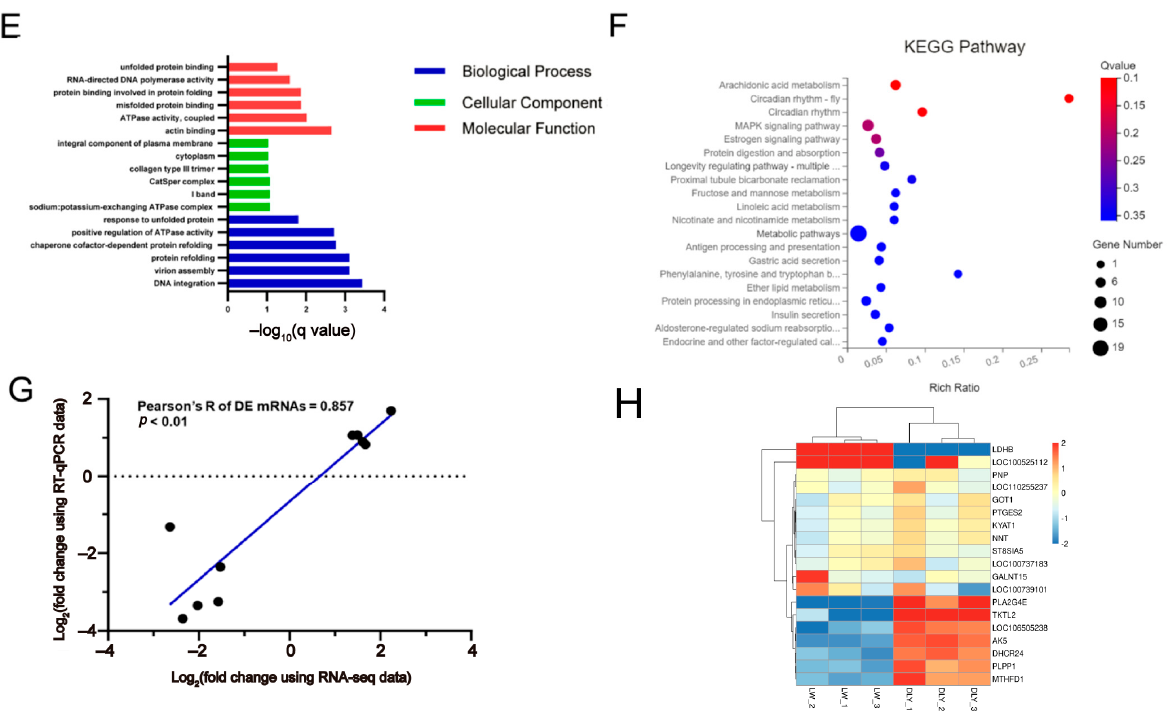
Figure 2. Expression profiles and bioinformatic analysis of DE mRNAs. ( A ) The volcano plots of the significantly differentially expressed mRNAs at the criteria of |log 2 (foldchange)| > 1 and q value < 0.05. ( B ) Heatmap plots of the significantly differentially expressed mRNAs. GO ( C ) and KEGG ( D ) analysis diagram of DE mRNAs upregulated in LW pigs. GO ( E ) and KEGG ( F ) analysis diagram of DE mRNAs downregulated in LW pigs. ( G ) Validation by RT-qPCR of 10 randomly selected DE mRNAs from RNA-seq. ( H ) Heatmap plots of the DE mRNAs in metabolic pathway. Table 3. The upregulated mRNAs in the Longissimus dorsi muscle sample of LW pigs according to q value threshold of <0.05 and log 2 (foldchange) >